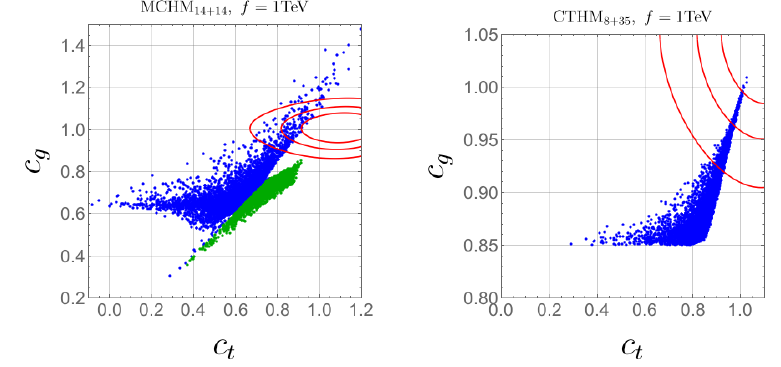
Figure 10 . The distribution of c t vs c g in models with high dimensional representations. The scale f is set to 1 TeV. The colored lines are 1 (cid:27) , 2 (cid:27) and 3 (cid:27) bounds coming from the Higgs signal global (cid:12)t using Run2 data. In the MCHM, the green points predict c t > c g thus the model has the problem of triggering EWSB [50], while the blue points satisfy c g > c t . In CTHMs, EWSB is automatically triggered as shown in section